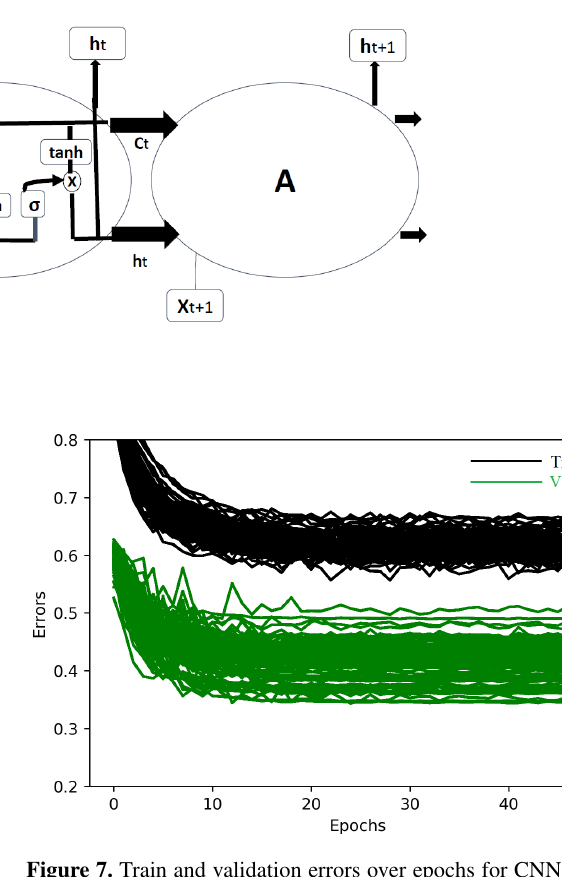
Figure 7. Train and validation errors over epochs for CNN-LSTM model with a noise